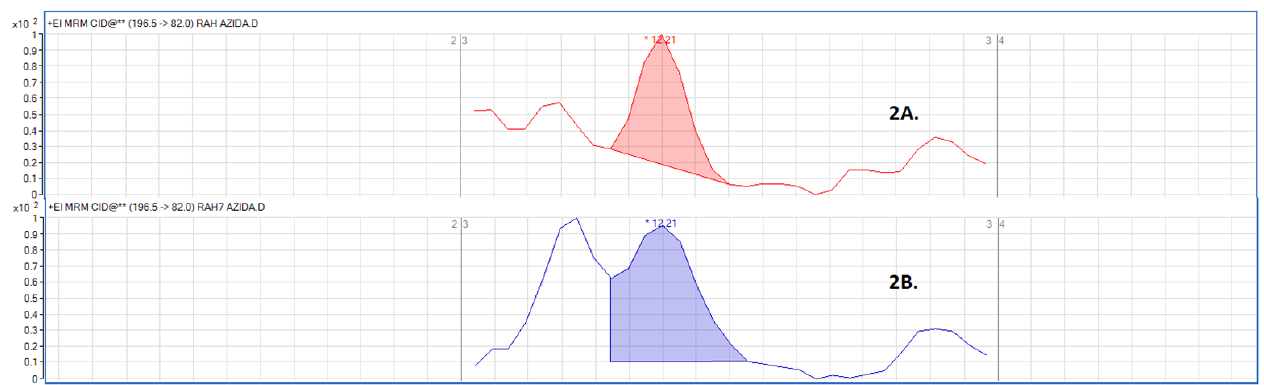
Figure 5. Chromatograms obtained for EME ( A ) and COET ( B ) for refrigerator temperature, absence of light, high concentration of preservative, day 1 (1A and 2A), and day 7 (1B and 2B) using sodium azide.